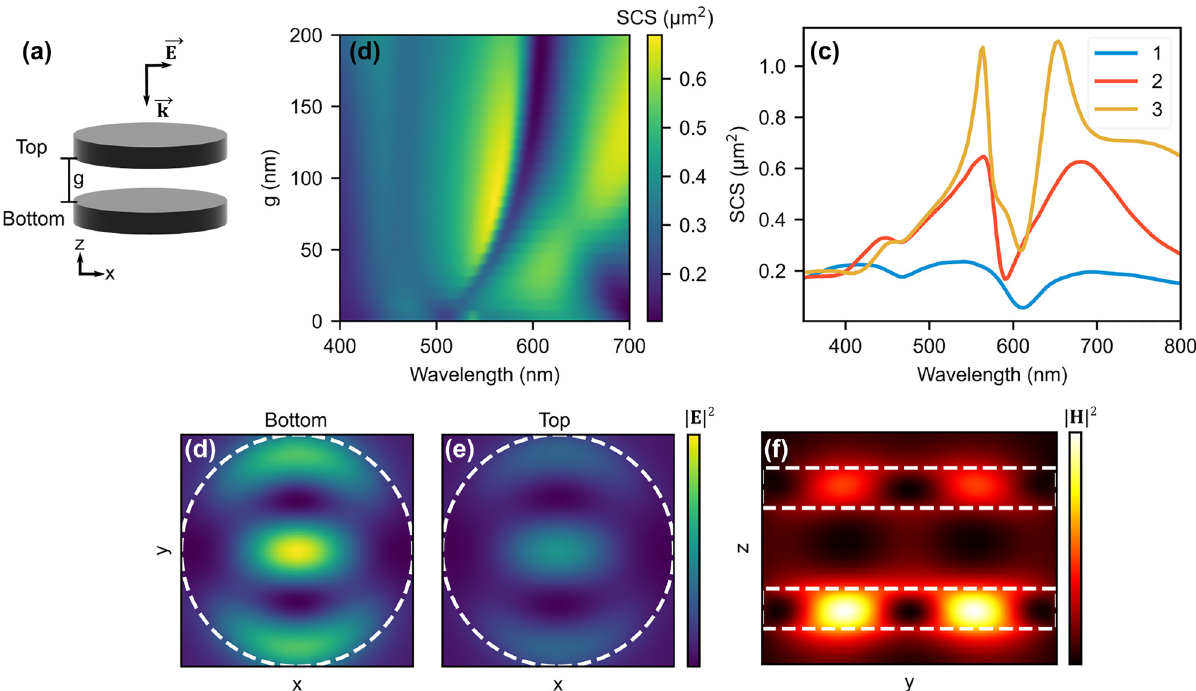
Figure 2: Scattering properties of two and three AlGaAs disks in air. (a) Schematic of two vertically stacked AlGaAs resonator separated by a gap distance of ‘ g ’. The incoming light is polarized in the x direction and traveling in the − z direction, as indicated by the ⃗ E and Effect of changing the spatial gap between the two resonators on total scattering cross-section. Lowering the gap below 100 nm blue shifts the anapole dip and increasing the gap moves the dip towards wavelength position where anapole is excited for individual nanodisk. (c) Simulated SCS for one, two and three disk structures. The gap between the disks is 100 nm in the case of two and three stacked resonators. (d), and (e) Cross-sectional (XY) profiles of electric field intensity for respective disk. (f) Cross-sectional (YZ) profile of magnetic field (590 nm) shows that the anapole is excited in both the top and the bottom